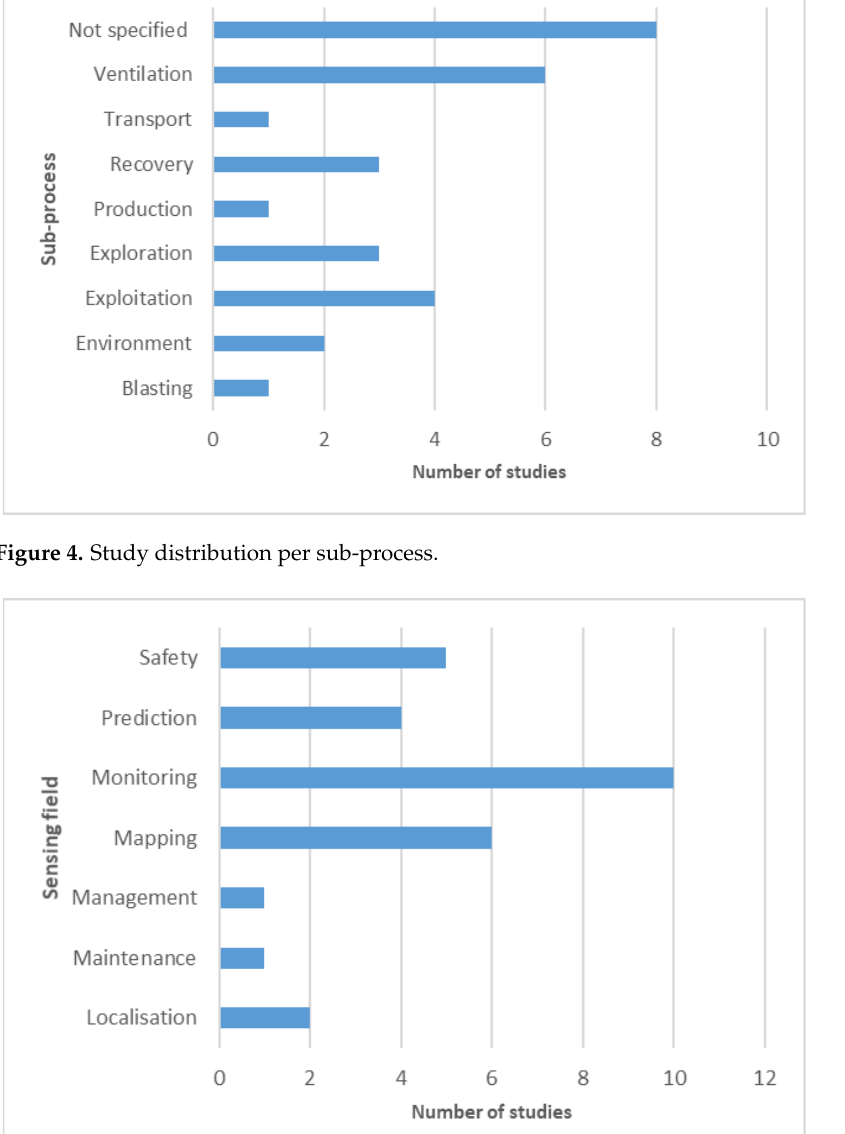
Figure 5. Study distribution per sensing field.